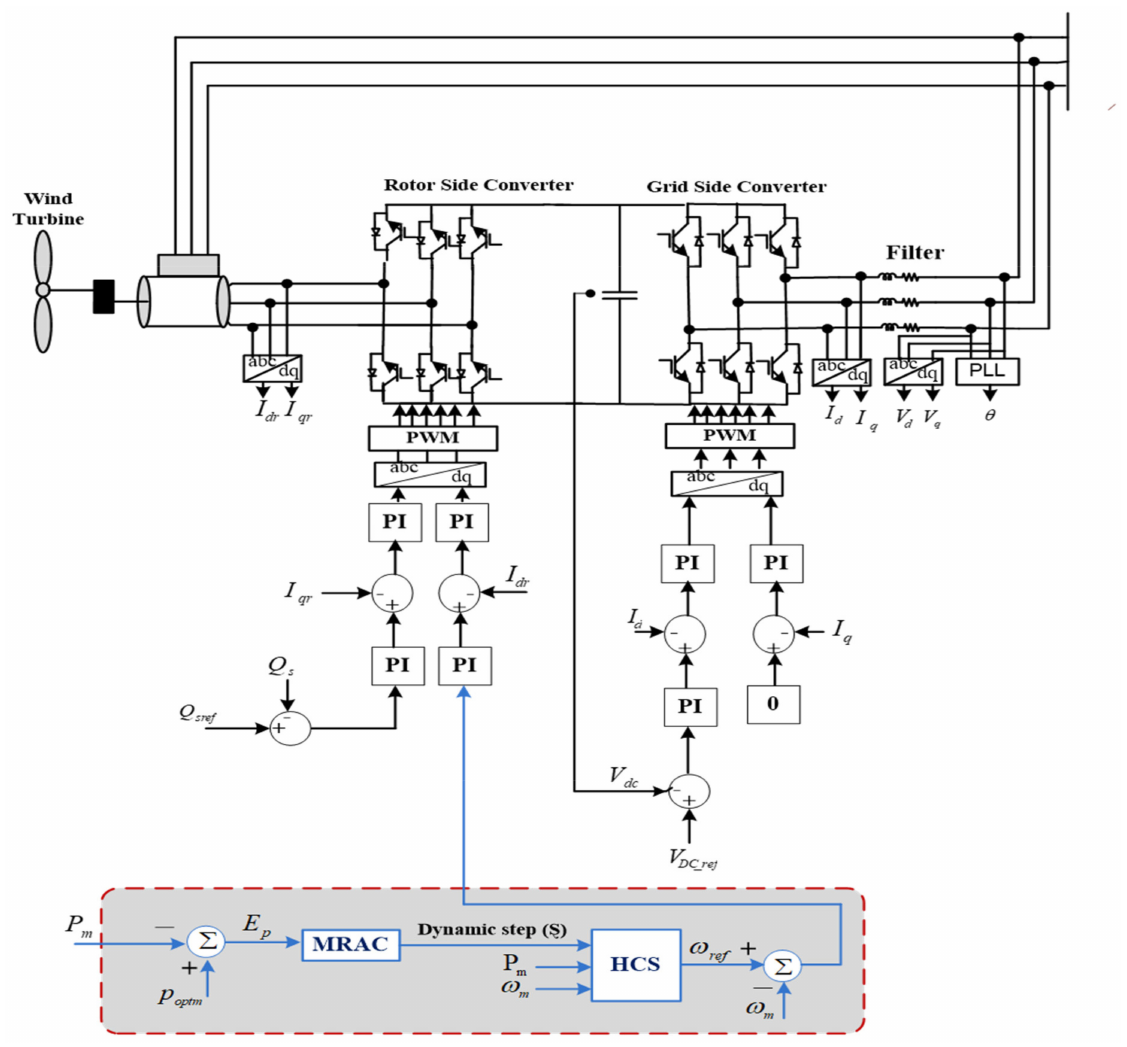
Figure 2. Studied